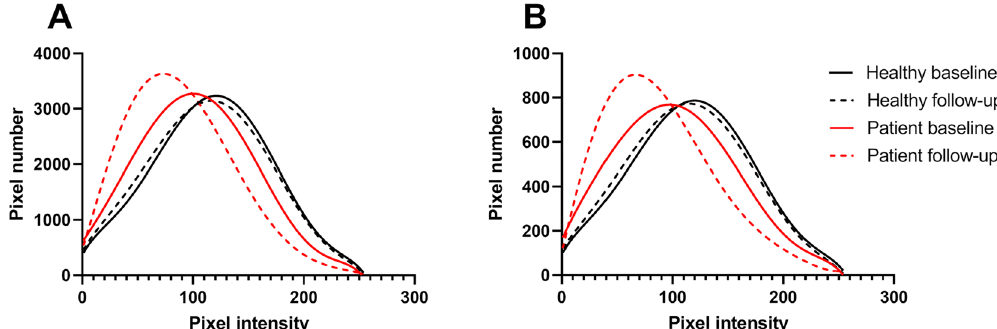
Figure 5. Plots illustrating the distribution of frequencies of grey level intensities in ( A ) the ring area and ( B ) the superior ring quadrant of patients and controls at baseline and 5-year follow-up. Mean pixel intensity distribution in healthy controls (n = 8) was identical at baseline and follow-up. Mean pixel intensity distribution in patients (n = 8) was non-identical at baseline and follow-up and different to patients’ distribution at both time points. Individual data points were fitted by sixth order polynomial nonlinear